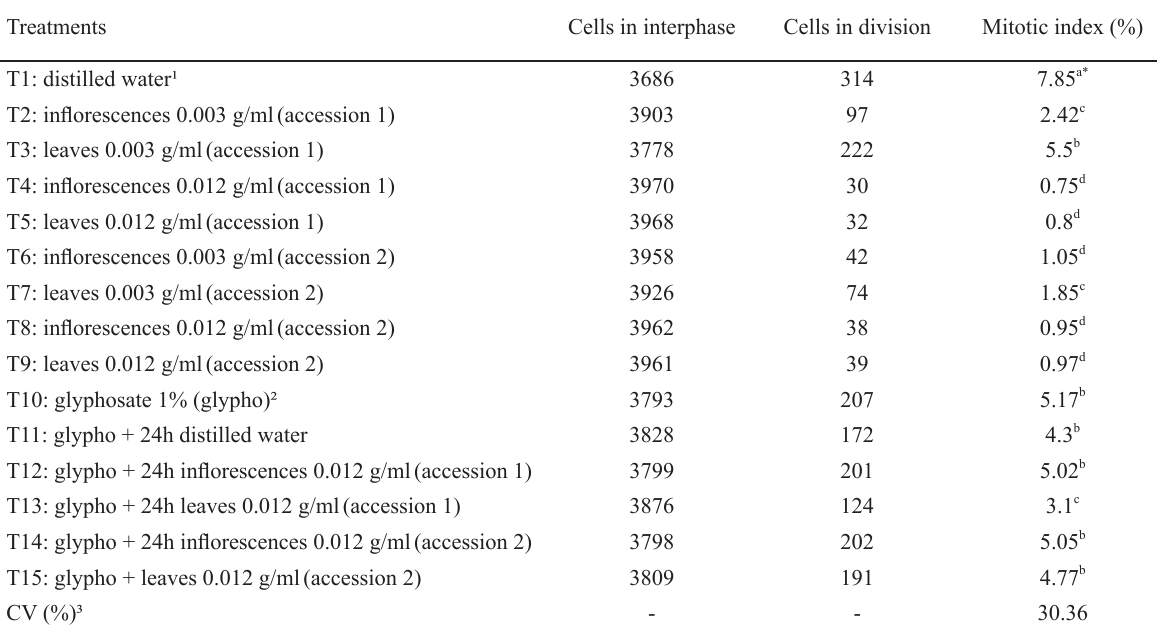
Number of cells in interphase and mitosis and the mitotic index of Allium cepa root tips for each treatment. Treatments Cells in interphase Cells in